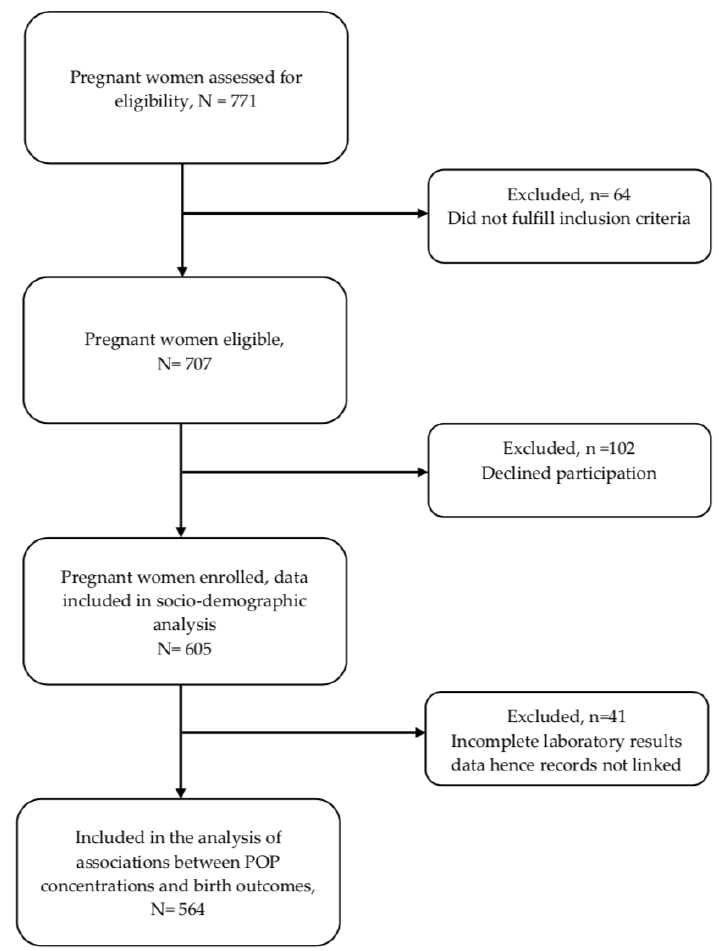
Figure 1. Flow chart of included and excluded participants.